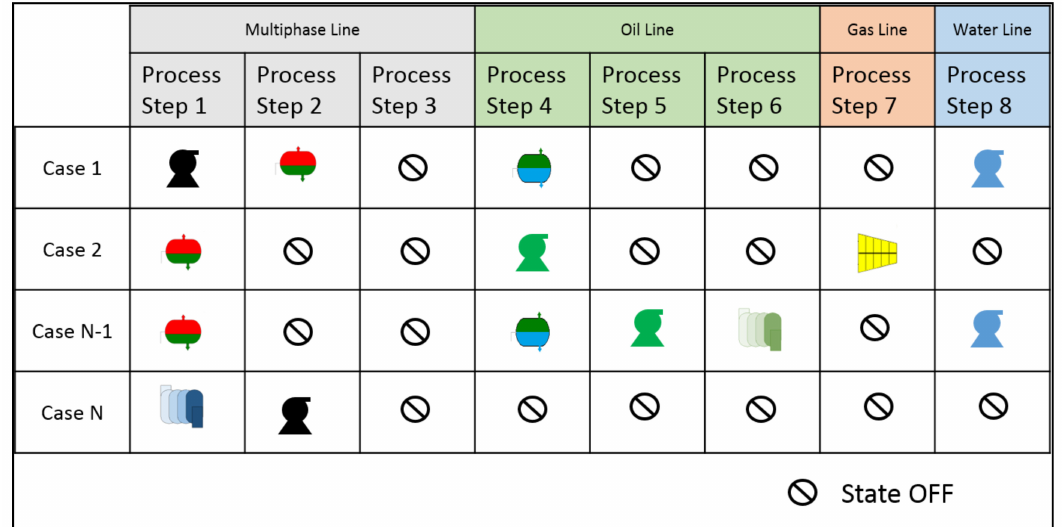
Figure 8. Example of a configuration